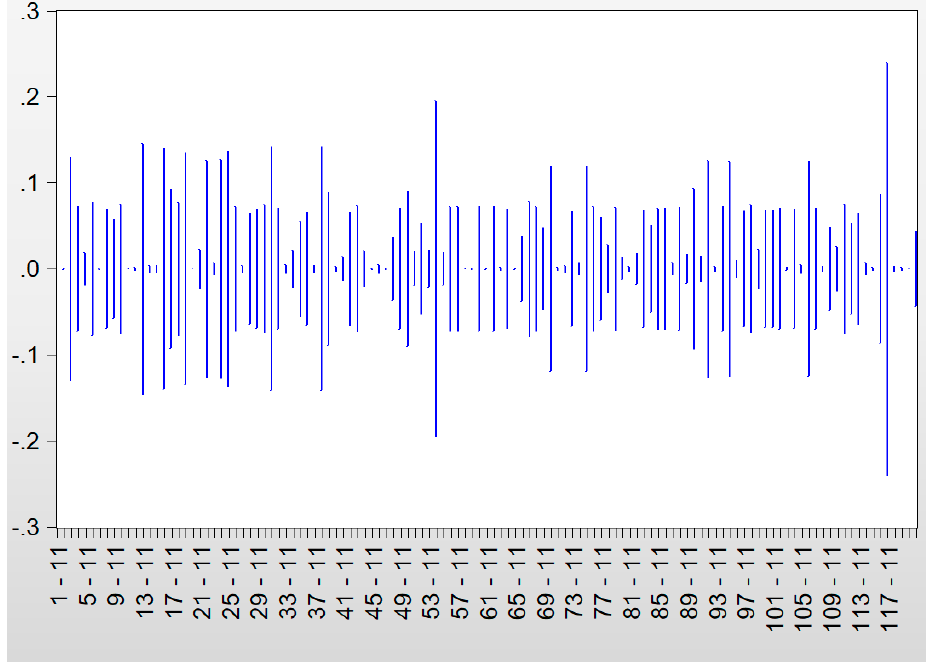
Figure 6. The influence of concentration of voting ownership on the quality of CGS after the COVID- 19 pandemic. Source: Author’s computations.